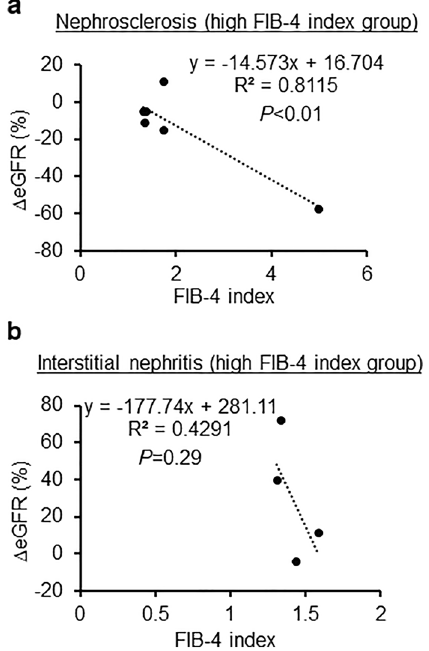
Figure 5. Associations between the change in estimated glomerular filtration rate and FIB-4 index in nephrosclerosis and IgA nephropathy of high FIB-4 index group. ( a ) Nephrosclerosis in high FIB-4 index group. ( b ) IgA nephropathy in high FIB-4 index group.